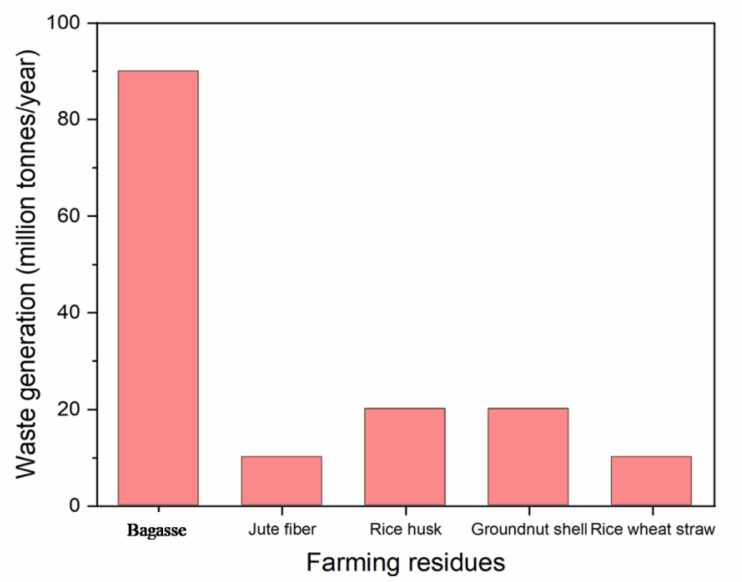
Figure 2. Graphical representation of the various agricultural wastes generated in